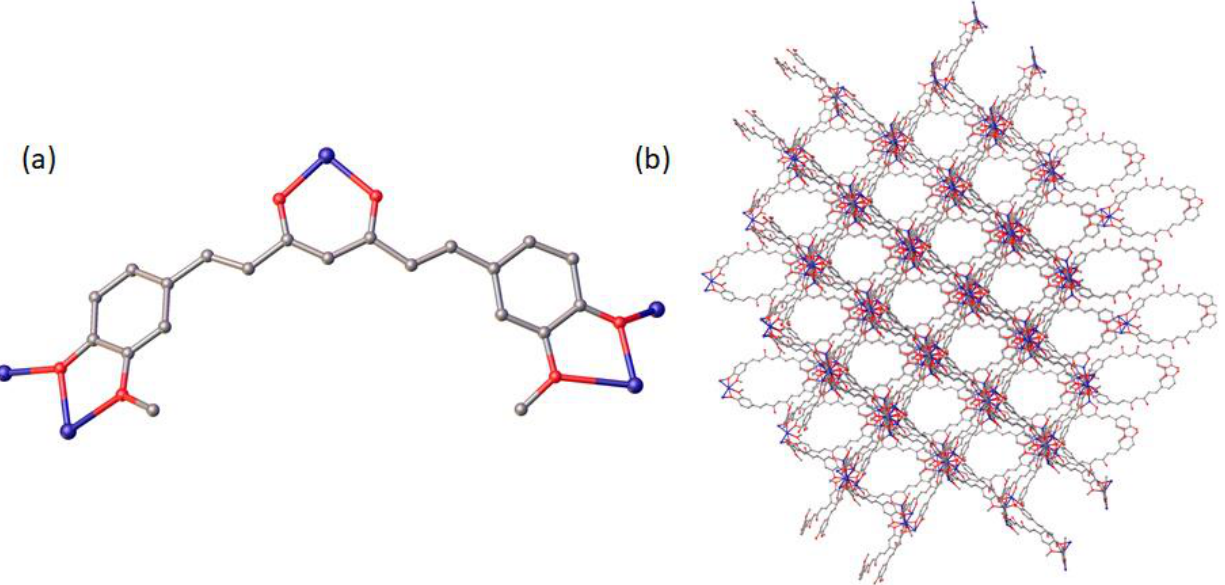
Figure 8. Structure of medi-MOF-1 constructed from bioactive linker curcumin, linker connectivity ( a ), framework viewed along [111] plane (b) (grey carbon, red oxygen, navy zinc, hydrogens omit ( a ), framework viewed along [111] plane ( b ) (grey carbon, red oxygen, navy zinc, hydrogens omit for for clarity) [222]. Adapted from ref. 222 with permission. clarity) [222]. Adapted from ref. [222] with